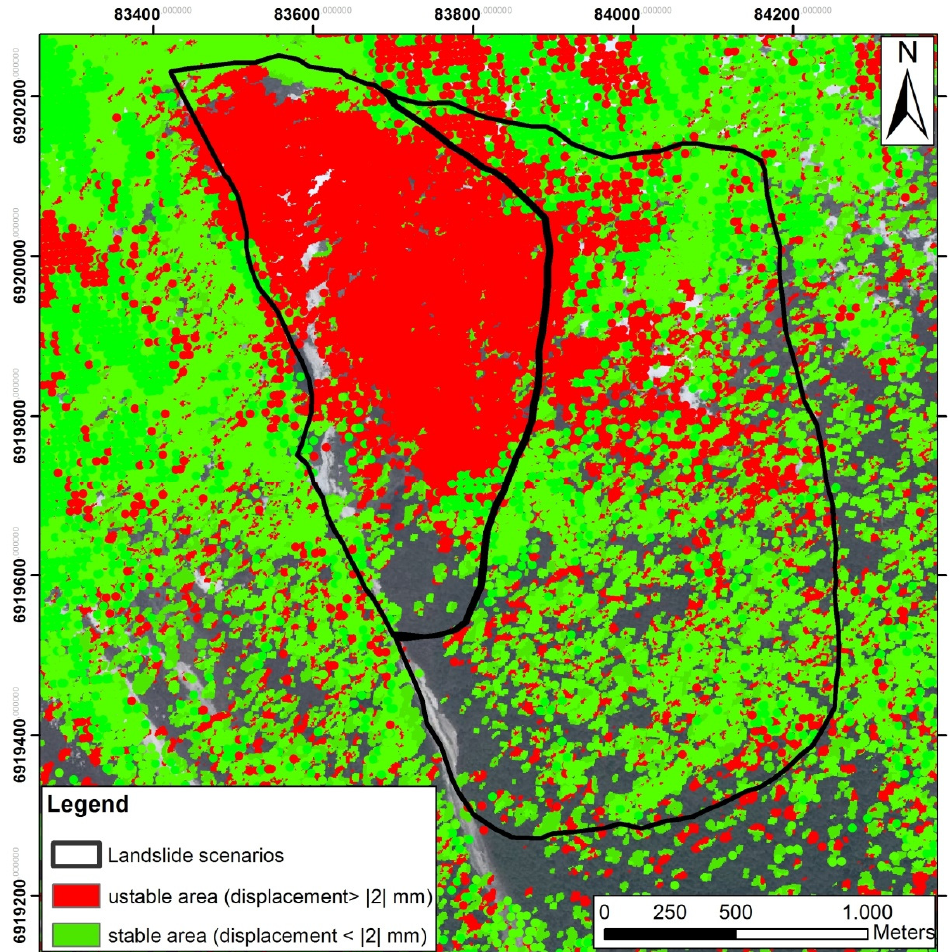
Figure 9. Qualitative integration between GB-InSAR available datasets (Figures 6 and 7) and RADARSAT-2 and TerraSAR-X/Tandem-X datasets (Figure 8). Data have been overlapped on an orthophoto of the study area. Unstable areas are displayed in red, whereas stable areas are shown in green.